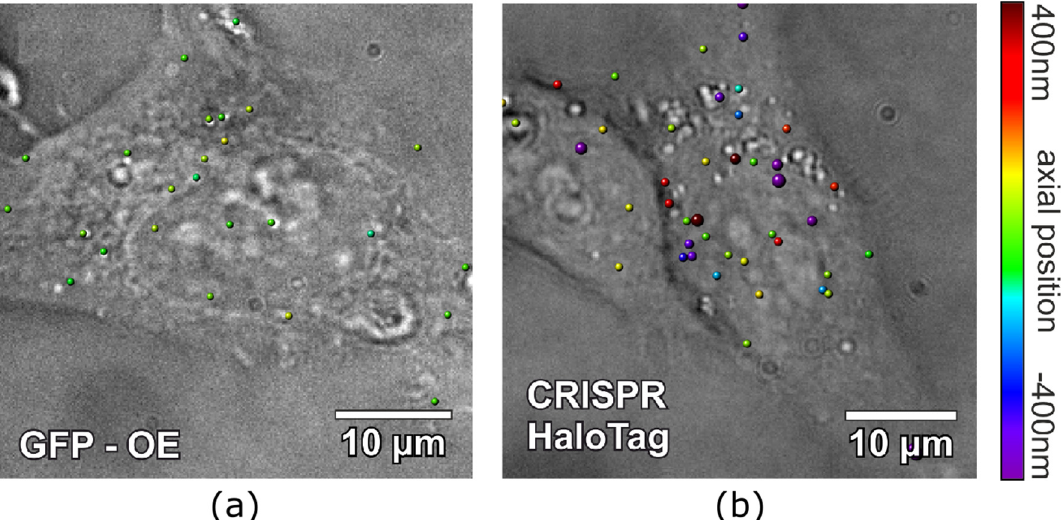
Figure 5. An overlay of EV localizations and brightfield image of the HeLa cells that were incubated with EVs. The colored dots represent the 3D localized position of EVs inside the cells. The diameter corresponds to the lateral position accuracy (multiplied by three for better visibility) of the localized EVs, the color corresponds to their z-position. ( a ) shows the 3D localizations of OE GFP-CD63 EV. ( b ) shows the 3D localizations of the CRISPR/Cas9-modified HaloTag ® EVs that were labeled with